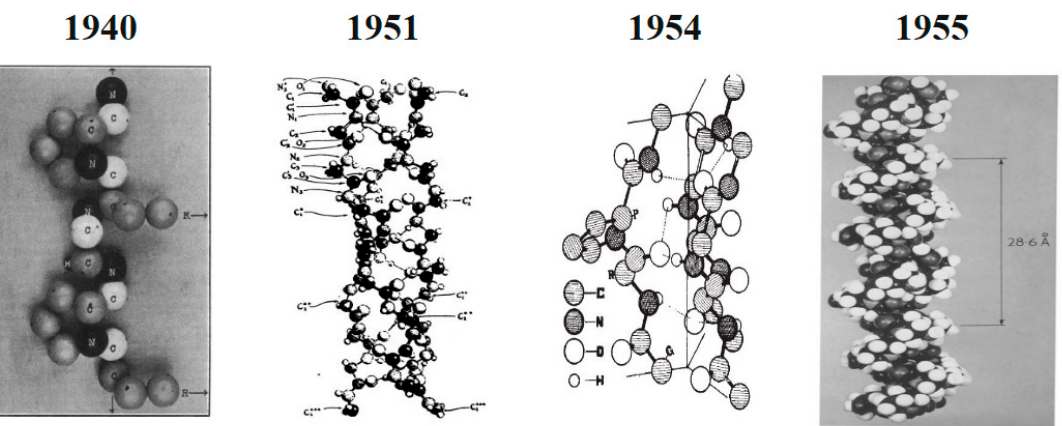
Figure 3. Changes in the proposed structure of type I collagen from the beginning and its modification to the final accepted structure. Adapted from [52]. Reproduced from [51] with permission from springer Nature, 1940. Reproduced from [53] with permission from springer Nature, 1954. Reproduced from [54] with permission from Elsevier, 1955.